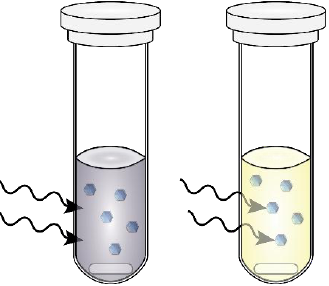
Figure 3. Drawing of two extremes of microwave-assisted reactions. The vial on the left contains a solution with a large tan δ (such as water). Upon microwave irradiation, the microwaves minimally penetrate the reaction volume due to efficient absorption by the solvent. On the right, a reaction with a solvent with a small tan δ (such as an alkane) is shown, and the microwaves can penetrate into the reaction solution. The reactants in the solution have a larger tan , and can interact, increasing temperature. Figure 4. Photographs of a typical 10 mL microwave reaction vessel with a stir-bar and fiber-optic thermometer insert ( left ) and the fiber-optic thermometer ( right ). The glass insert provides values of the internal temperature, but is limited by response time and heat transfer through the insert.